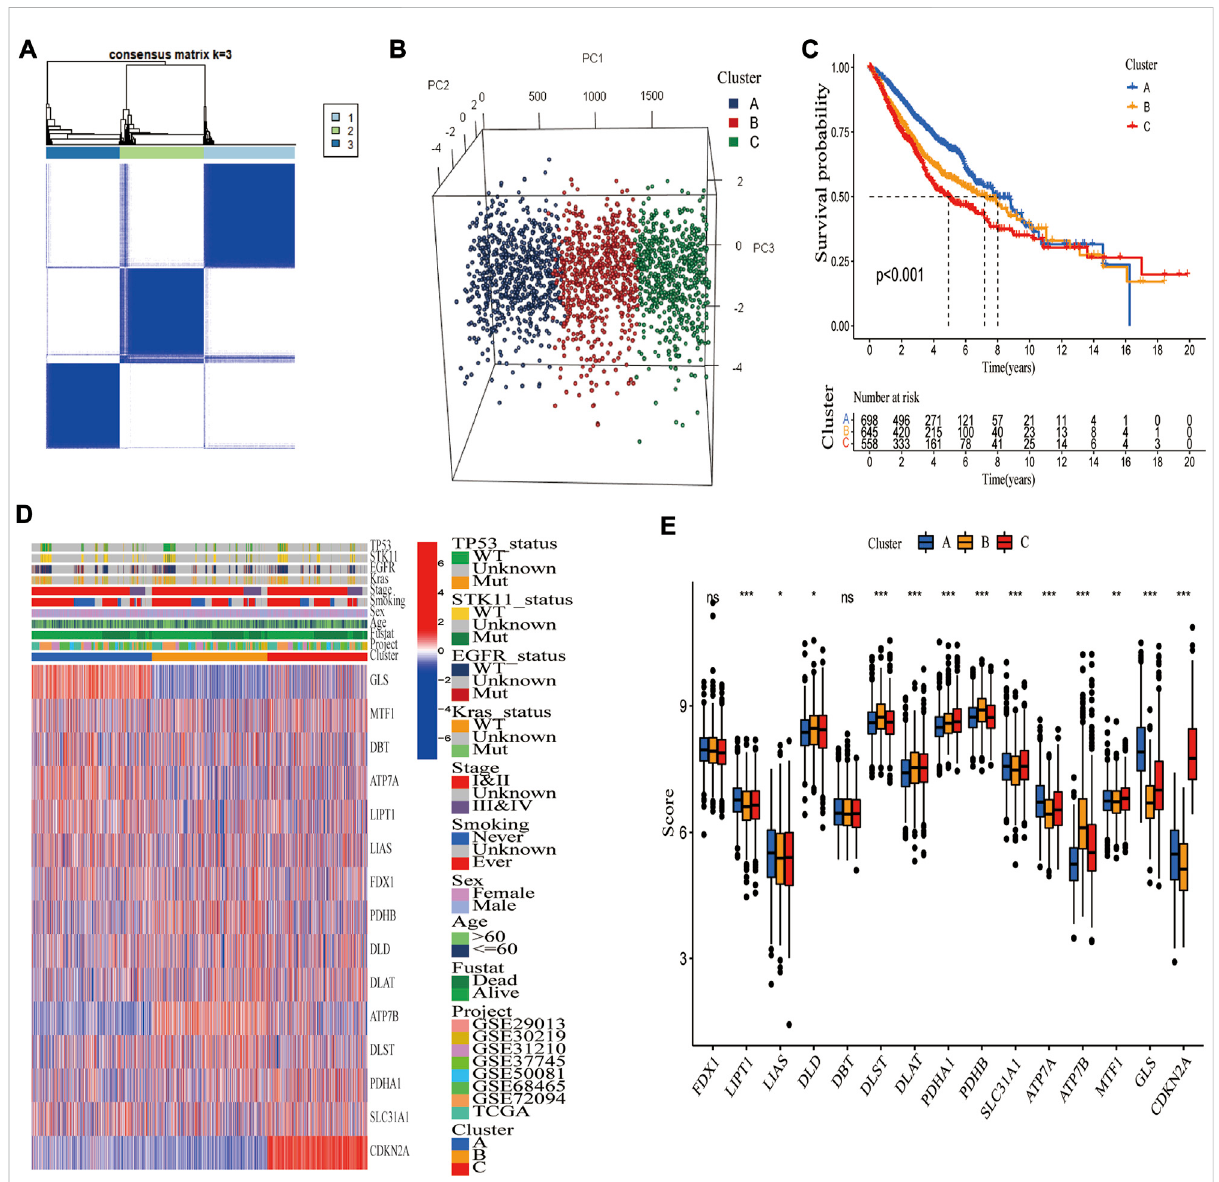
FIGURE 3 Identi fi cation of three cuproptosis molecular subtypes in the merged cohort. (A) Unsupervised consensus clustering identi fi ed three molecular subtypes of cuproptosis. (B) PCA veri fi ed that the merged cohort could be well classi fi ed into three molecular subtypes. (C) Kaplan-Meier analysis showed signi fi cant differences in overall survival between the three molecular subtypes. (D) Heatmap demonstrating differences in CRGs transcript and clinical features among three molecular subgroups (blue, low expression level; red, high expression level). (E) Thirteen CRGs were differentially expressed among three molecular subgroups. *, **, and ***, represent p < 0.05, p < 0.01, and p < 0.001,